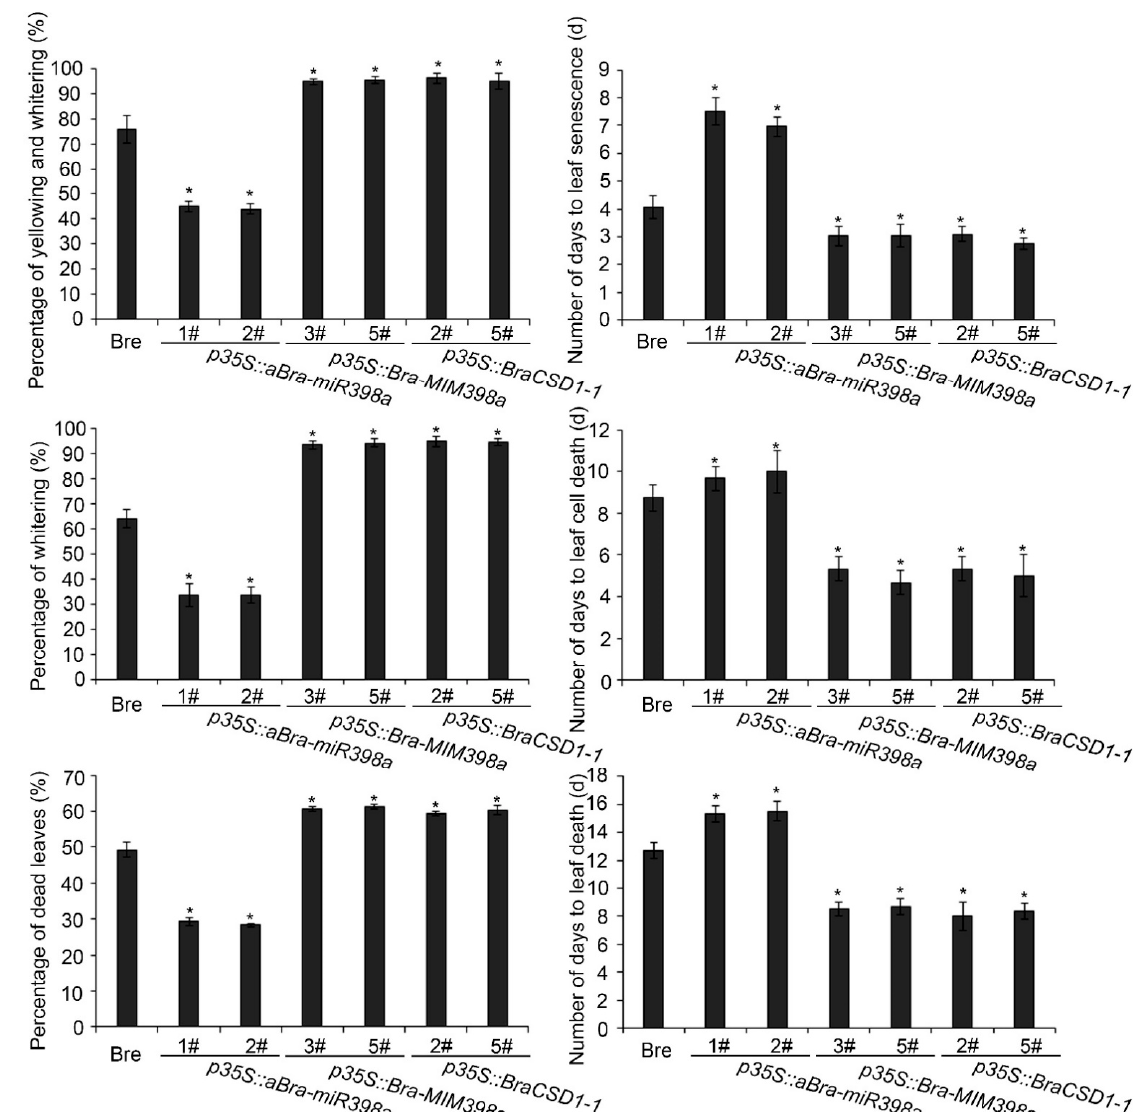
Figure 4. Leaf cell death under high-temperature treatment (45 °C 12 h followed by 35 °C 12 h). The result showed that the percentage of yellow (senescence) and white (cell death) leaf areas, percentage of white leaf areas, percentage of the dead leaves, number of days to senescence, number of days to leaf cell death, and number of days to leaf death of Bre, p35S::aBra-miR398a (1#, 2#), p35S::Bra- MIM398a (3#, 5#), and p35S::BraCSD1-1 (2#, 5#) plants. More than 20 leaves for each treatment were harvested and measured from the fourth node of plants. The asterisks indicate a significant difference (* represents p < 0.05) (Student’s t -test).